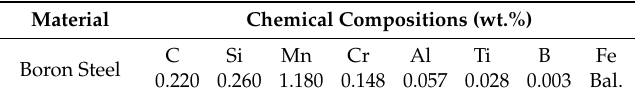
Table 1. Chemical composition of boron steel used in this study.